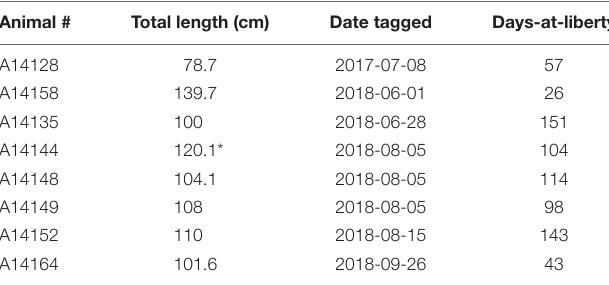
*Calculated from measured fork length using unpublished total length-fork length conversion equation.